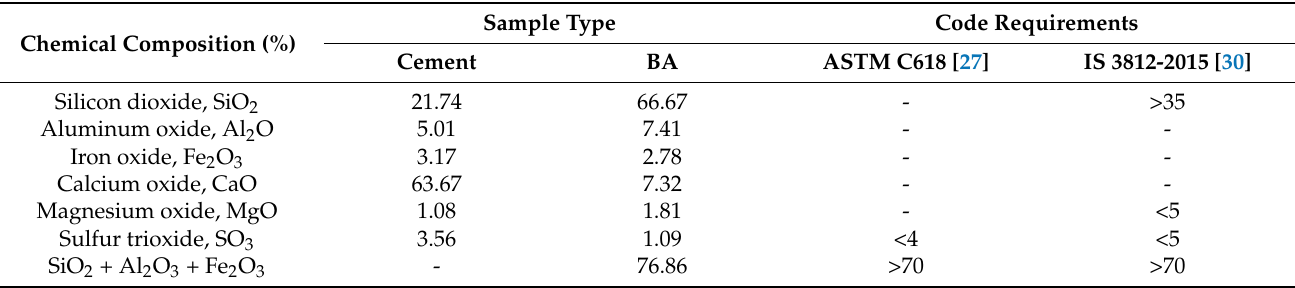
Table 3. Chemical compositions of OPC and